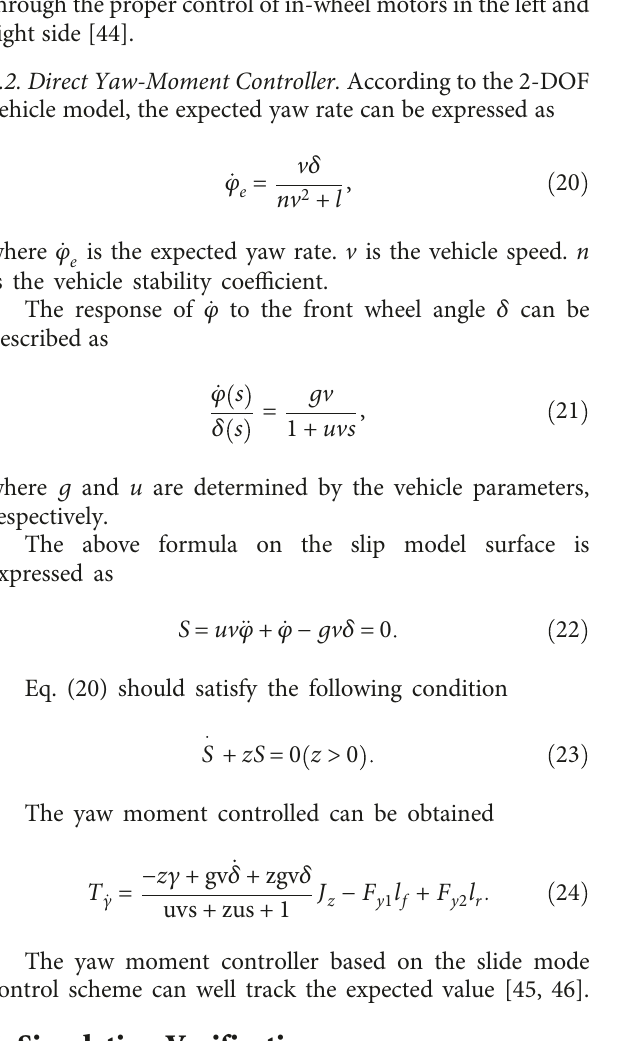
Figure 8: Comparison of vehicle